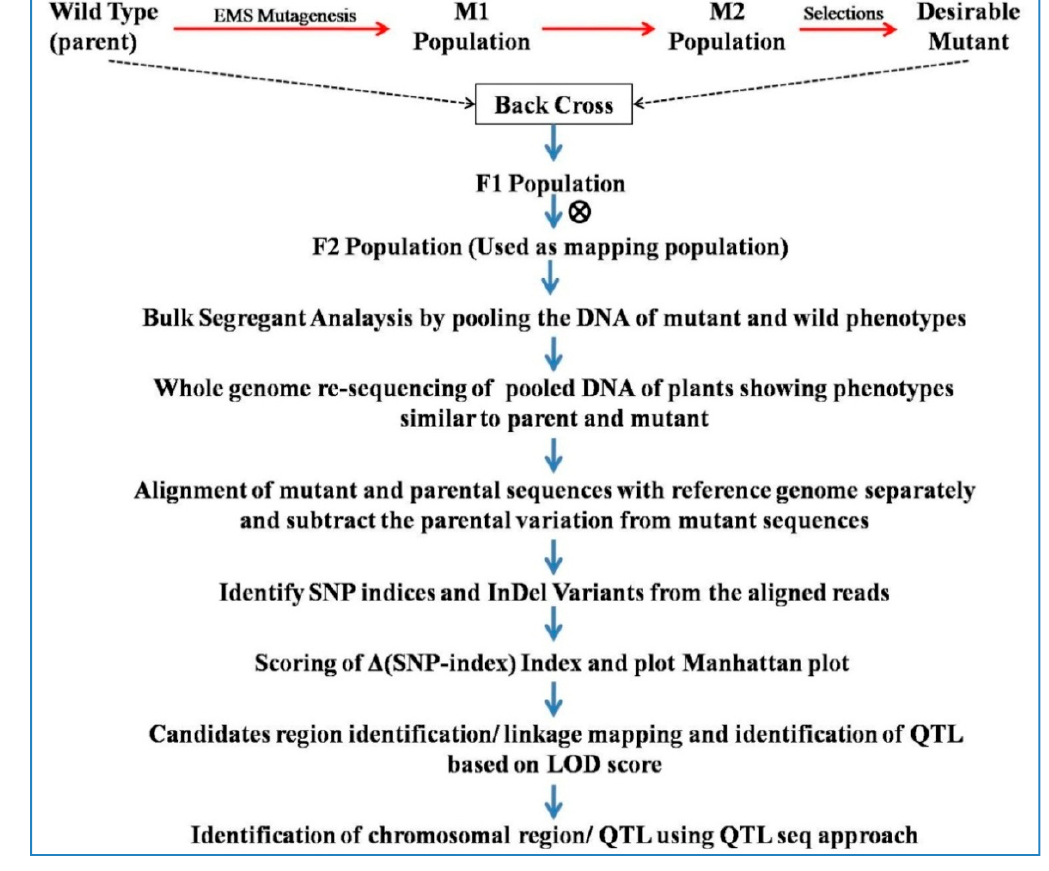
Figure 5. Flow diagram showing the major steps of quantitative trait loci (QTL) seq approach.